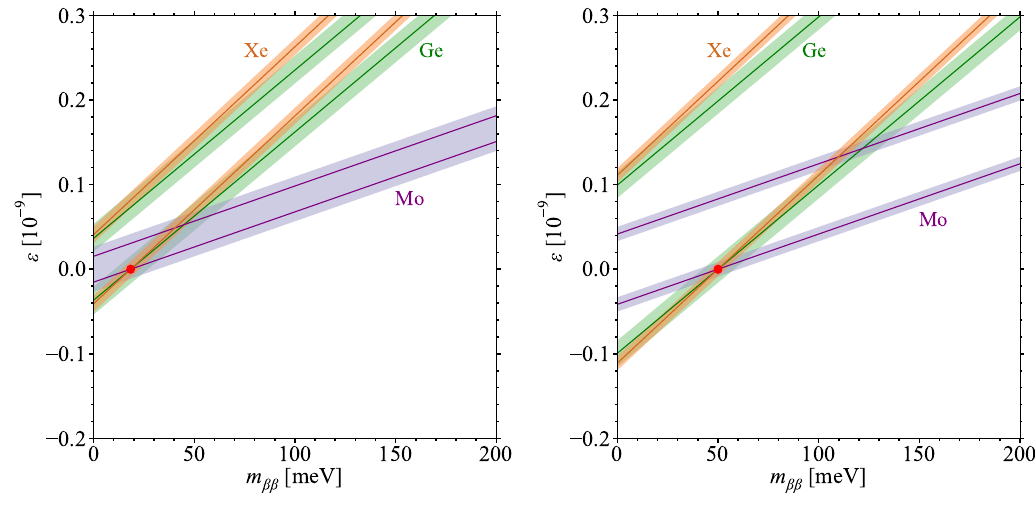
Figure 1 . Parameter space allowed for the effective Majorana mass m ββ and short-range coupling (cid:15) assuming future measurements of the 0 νββ -decay half-life of 136 Xe (orange space), 76 Ge (green) and 100 Mo (purple). The measurements are assumed to have a central value corresponding to the half-life expected for (cid:15) = 0 and m ββ = 18 . 4 meV (left) or 50 meV (right), and to be affected by a 1 σ statistical uncertainty as described in section 5. NME values are fixed to the best-fit estimates in eq. (4.4) and table